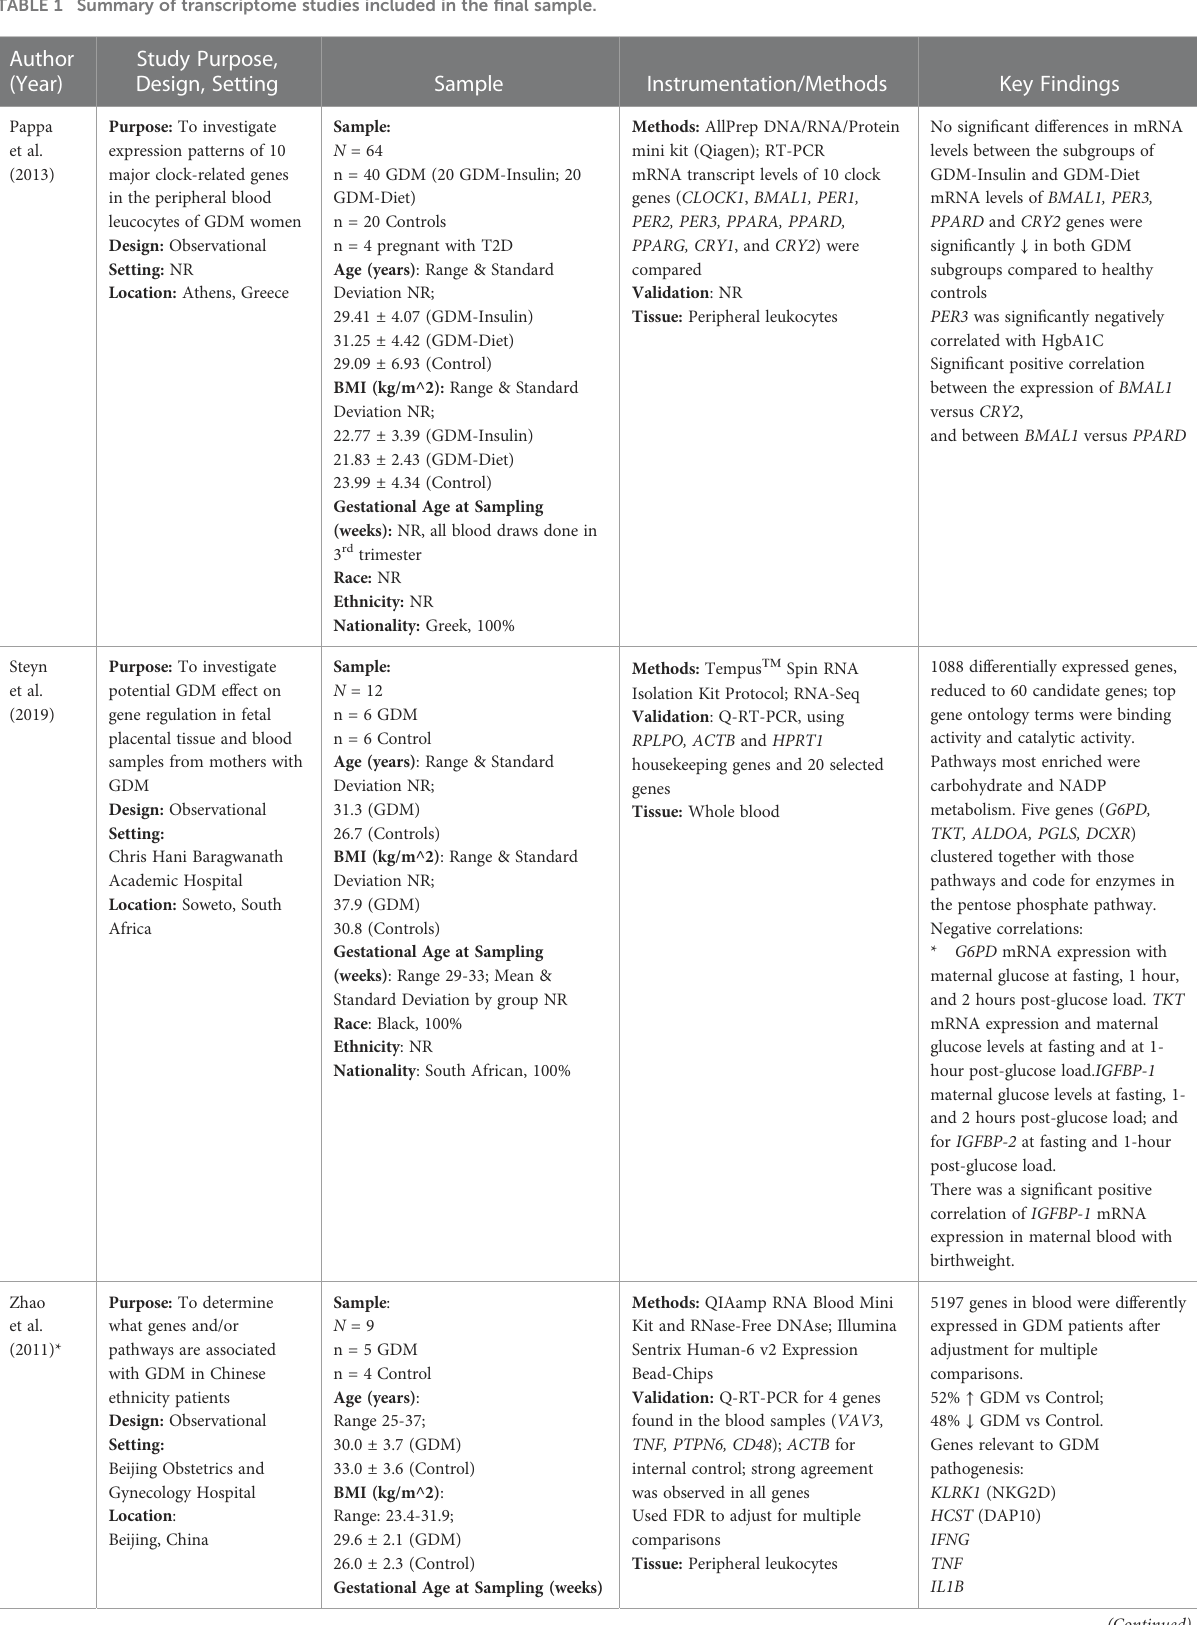
TABLE 1 Summary of transcriptome studies included in the fi nal